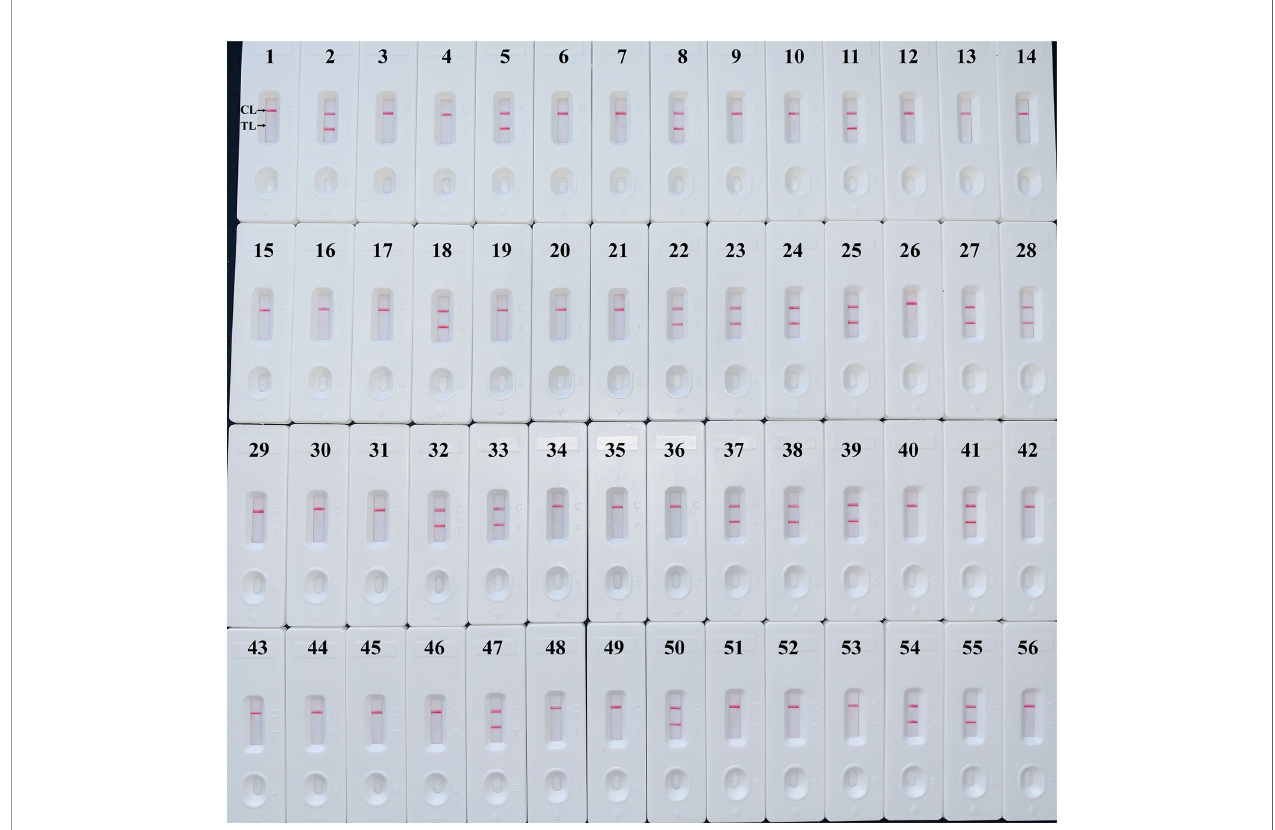
FIGURE 6 | Sensitivity of MCDA-LFB assay for detecting H. in fl uenzae in clinical samples. Later fl ow biosensor was applied for detecting MCDA amplicons. The numbers 2, 5, 8, 11, 18, 22 – 25, 27, 28, 32, 33, 37 – 39, 41, 47, 50, 54, 55 represented the positive results. Other numbers represented the negative results.